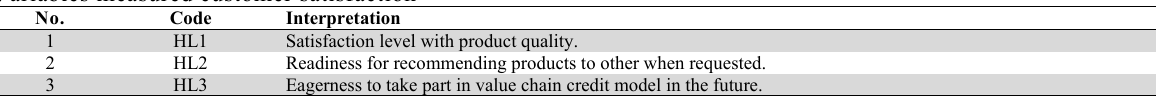
Variables measured customer